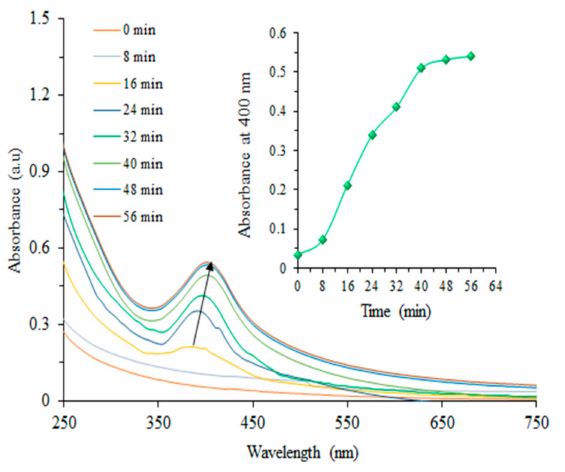
Figure 3. Time based UV-Vis spectra during preparation of biogenic CAg-nPs.